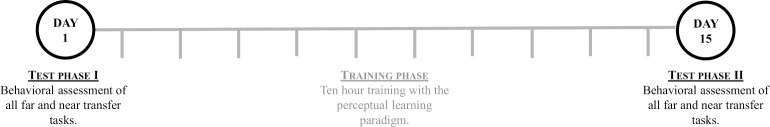
A visual timeline infographic of the study.